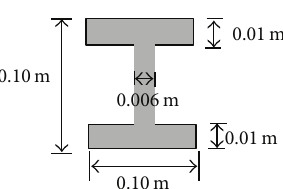
Figure 13: Cross-section of the stiffener of Example 3.